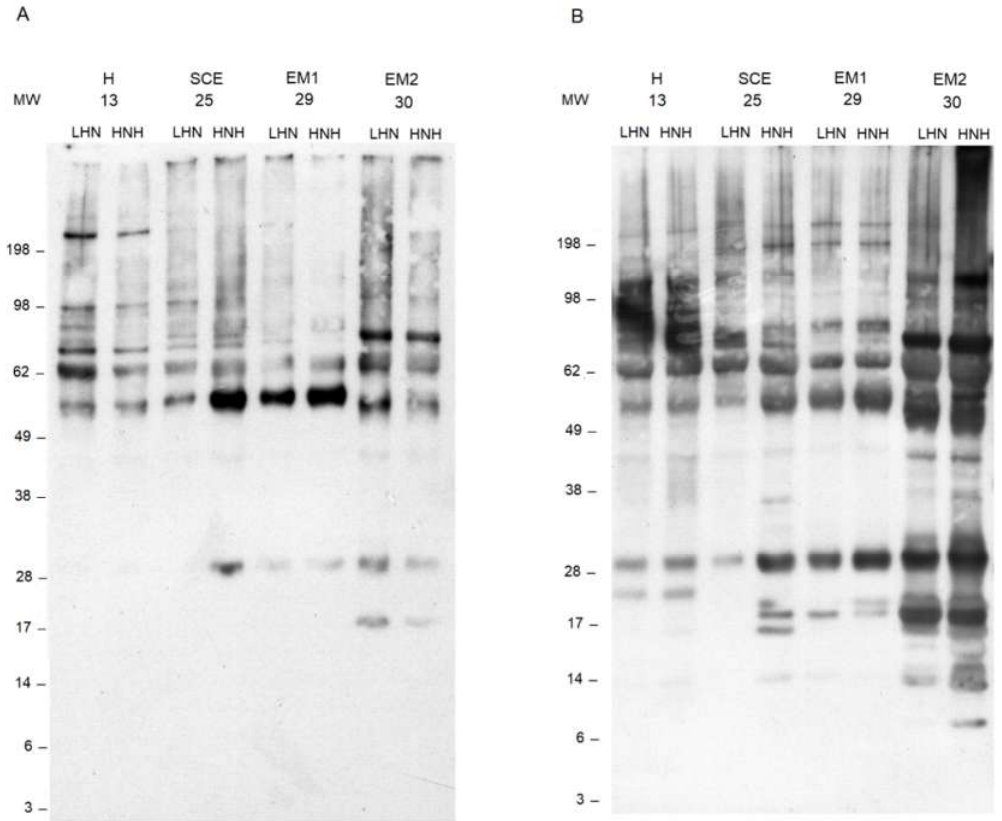
Figure 4. Western blot analyses of carbonyl groups ( A ) and dityrosine ( B ) detected in the uterine horn lavage (UHL) fluids, with the higher and lower neutrophil percentage (HNH) and (LNH), respectively, collected from four representative cows. MW. molecular weights; H (Healthy cows): Clinically healthy subjects with PMN < 5%, one week after the clinical evaluation; SCE (Subclinical Endometritis): Clinically healthy subjects and PMN ≥ 5%, one week after the clinical evaluation; EM1 (Grade 1 Endometritis): Animals with grade 1 clinical endometritis and PMN ≥ 5%, one week after the clinical evaluation; EM2 (Grade 2 Endometritis): Animals with grade 2 clinical endometritis and PMN ≥ 5%, one week after the clinical evaluation.